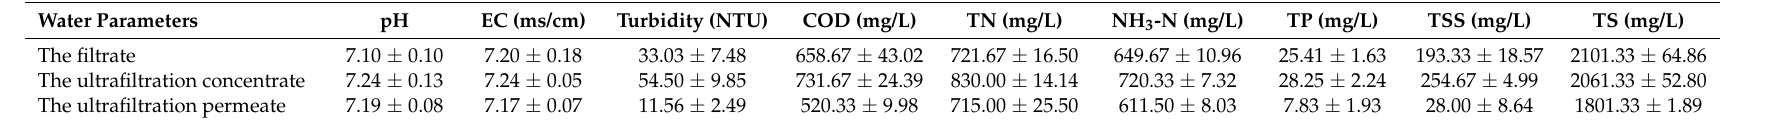
Table 5. The water parameters of the paper filtration filtrate, the ultrafiltration concentrate and the ultrafiltration permeate (mean ± SD).